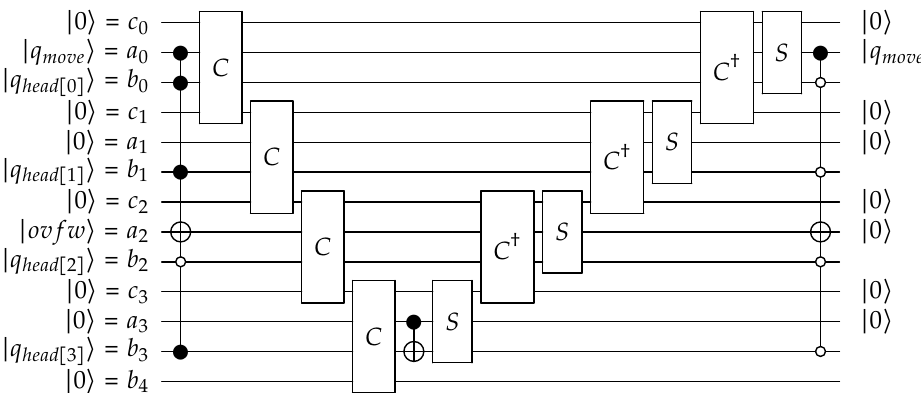
Figure A5. Modulo-12 quantum adder for implementing move tape head for QPULBA